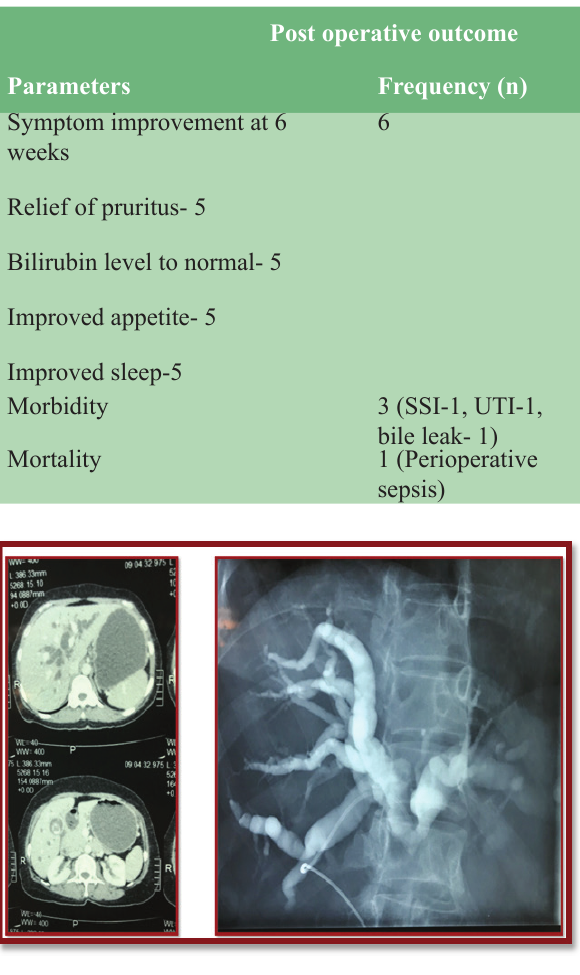
Figure 1. Hilar obstruction due to carcinoma Gallbladder